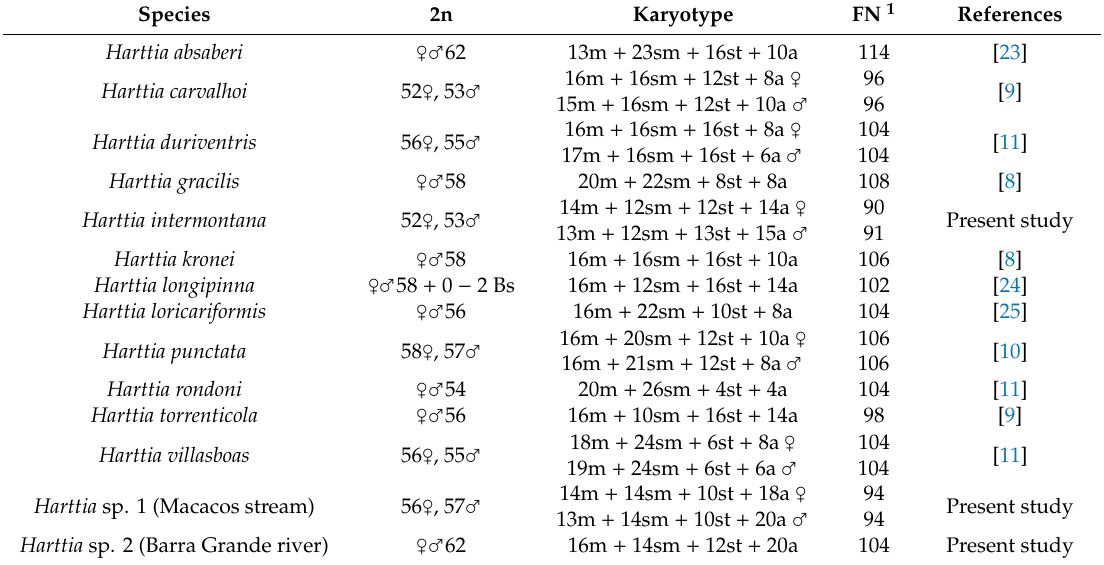
Table 1. Available cytogenetic data for Harttia species.